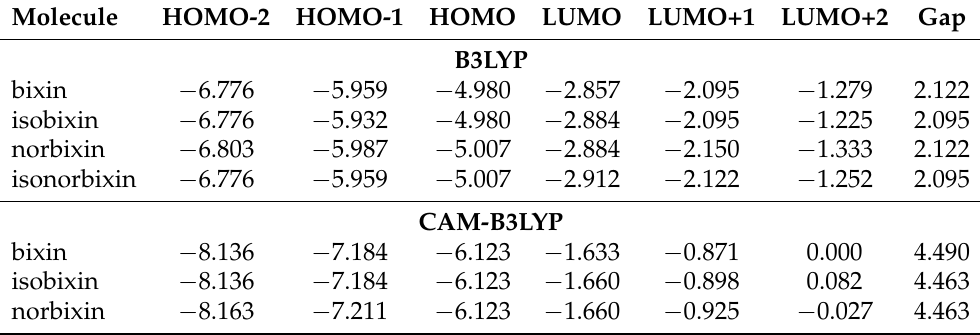
Table A10. Frontier MOs and gap energy values for the dyes in chloroform solution. These results were obtained by employing the 6-31G basis set. All values are in electron-Volt